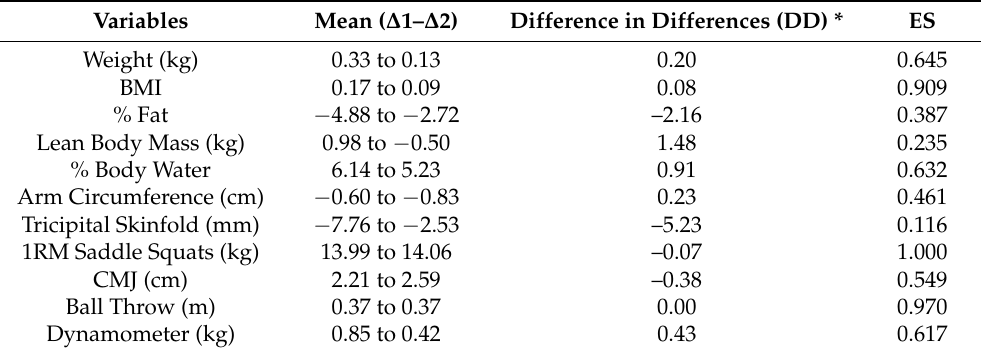
Table 2. Comparison of body composition and sports performance variables in the morning